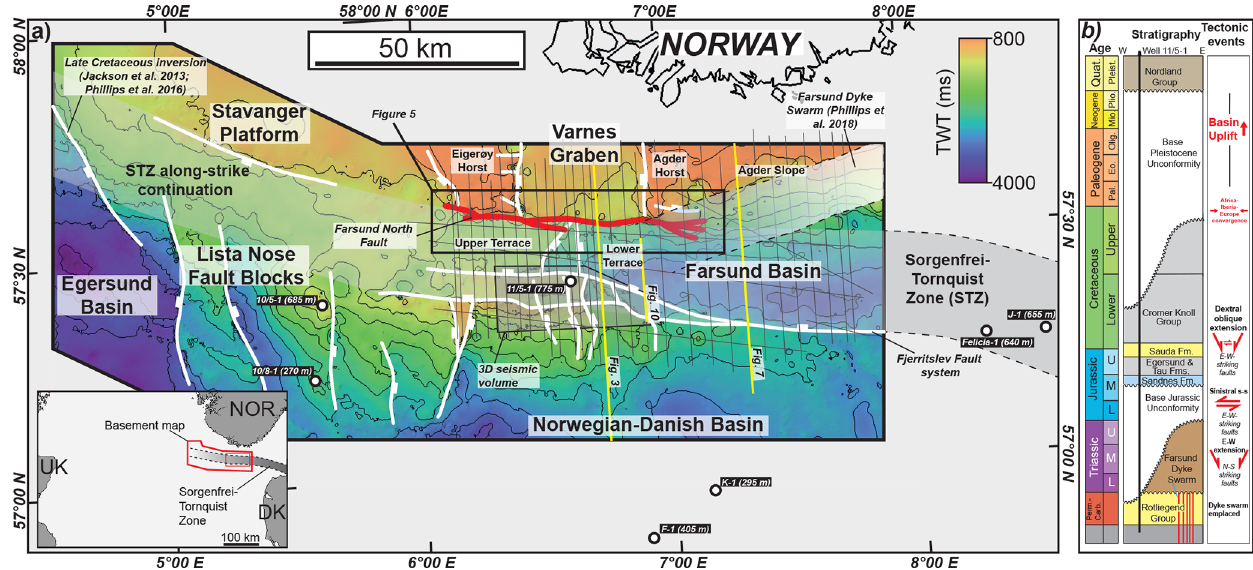
Figure 2. (a) Regional two-way-time (TWT) structure map showing the top acoustic basement surface (typically base Triassic/base Zechstein Supergroup evaporites) across the region. The locations and calculated total uplift values of wells, used to constrain the ages of stratigraphic horizons across the area are shown. Grey lines indicate the locations of 2D seismic lines referred to in this study. Seismic data used to create the rest of the acoustic basement surface can be found in Phillips et al. (2016). Inset – Regional map showing the location of the study area and Sorgenfrei-Tornquist Zone. (b) Tectonostratigraphic column for the Farsund Basin based on lithological information from well 11/5-1 (after Phillips et al., 2019), showing the main lithologies and tectonic